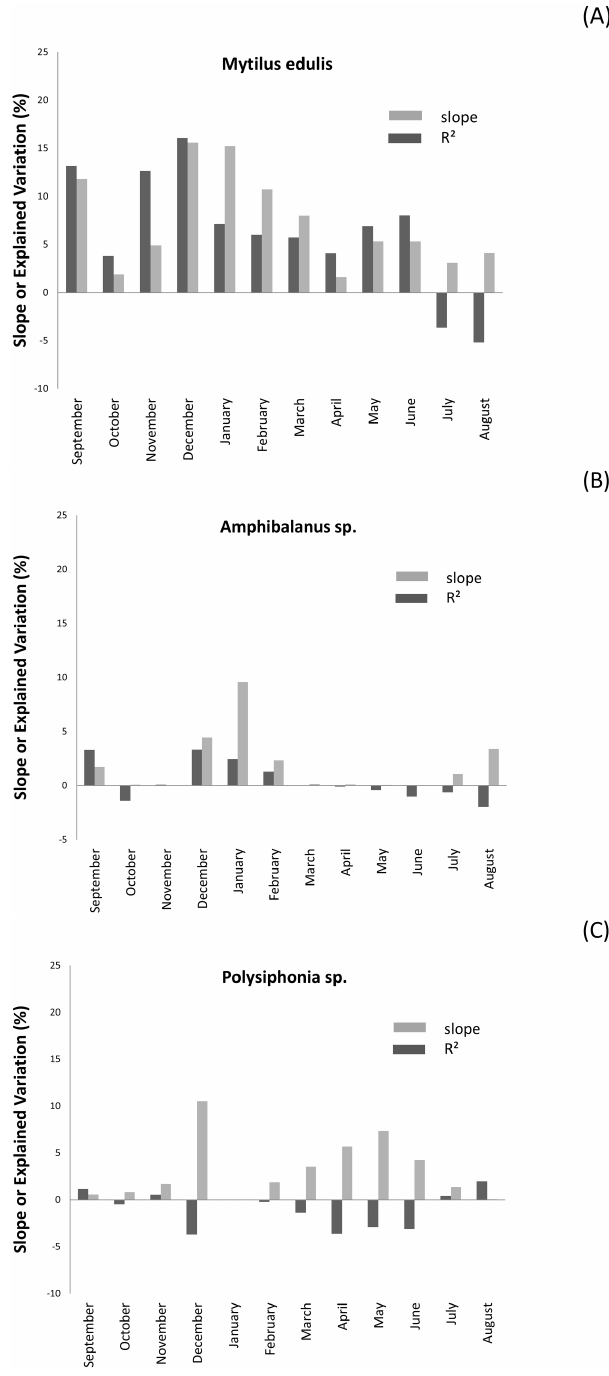
Fig. 13. Relationship (slopes and explained variance R 2 ) between monthly mean SST and the relative abundance of (A) Mytilus , (B) Amphibalanus and (C) Polysiphonia in the communities establish- ing on the panels. In case of Mytilus 4 of the relationships were sig- nificant at p ≥ 0 . 05, while the number of significant findings was 1 in case of Amphibalanus and 0 for Polysiphonia